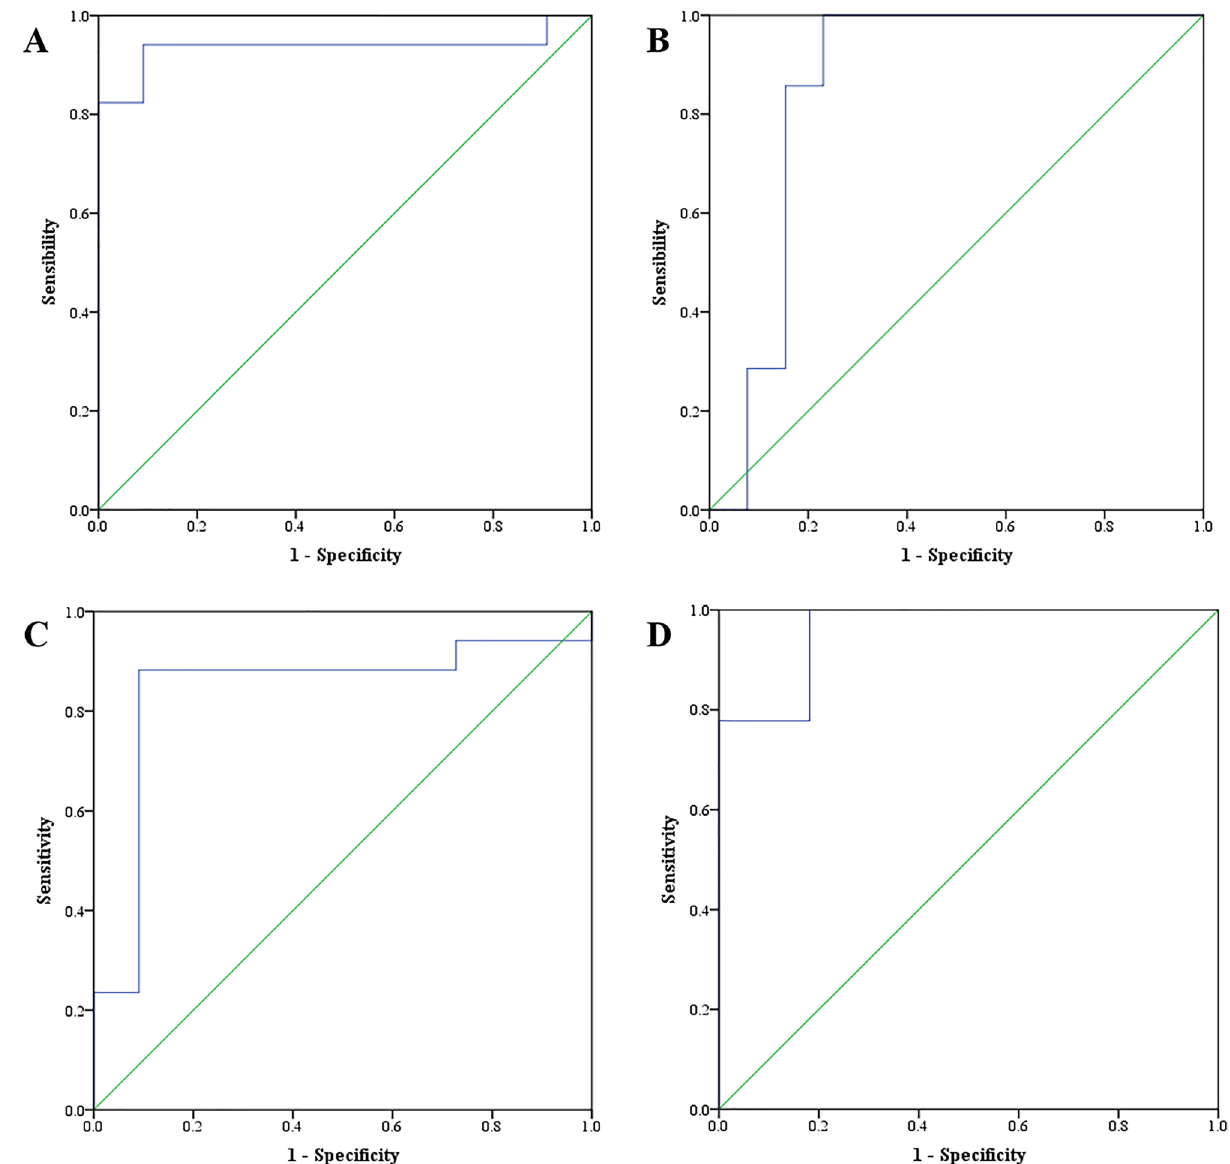
Figure 7. ROC curves of the LASSO model in predicting ELG function. ( A ) The ROC curve of the LASSO model in predicting ELG weight in the training set; ( B ) The ROC curve of the LASSO model in predicting ELG weight in the test set; ( C ) The ROC curve of the LASSO model in predicting the level of tear secretion in the training set; ( D ) The ROC curve of the LASSO model in predicting the level of tear secretion in the test